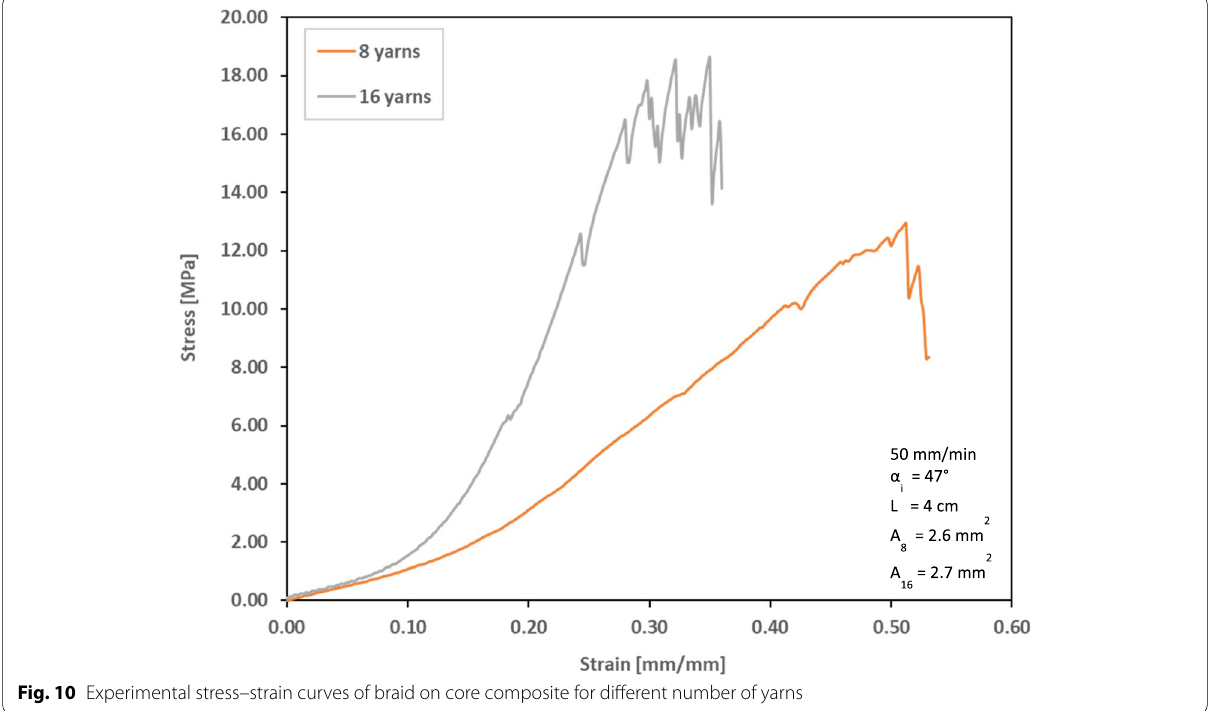
Fig. 10 Experimental stress–strain curves of braid on core composite for different number of yarns